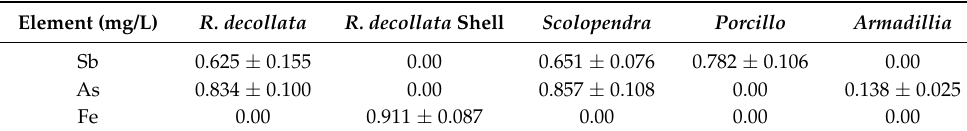
Table 1. Concentration of other metallic elements present in the filtrate of different terrestrial biota in mg/L. Element (mg/L) R. decollata R. decollata Shell Scolopendra Porcillo Armadillia